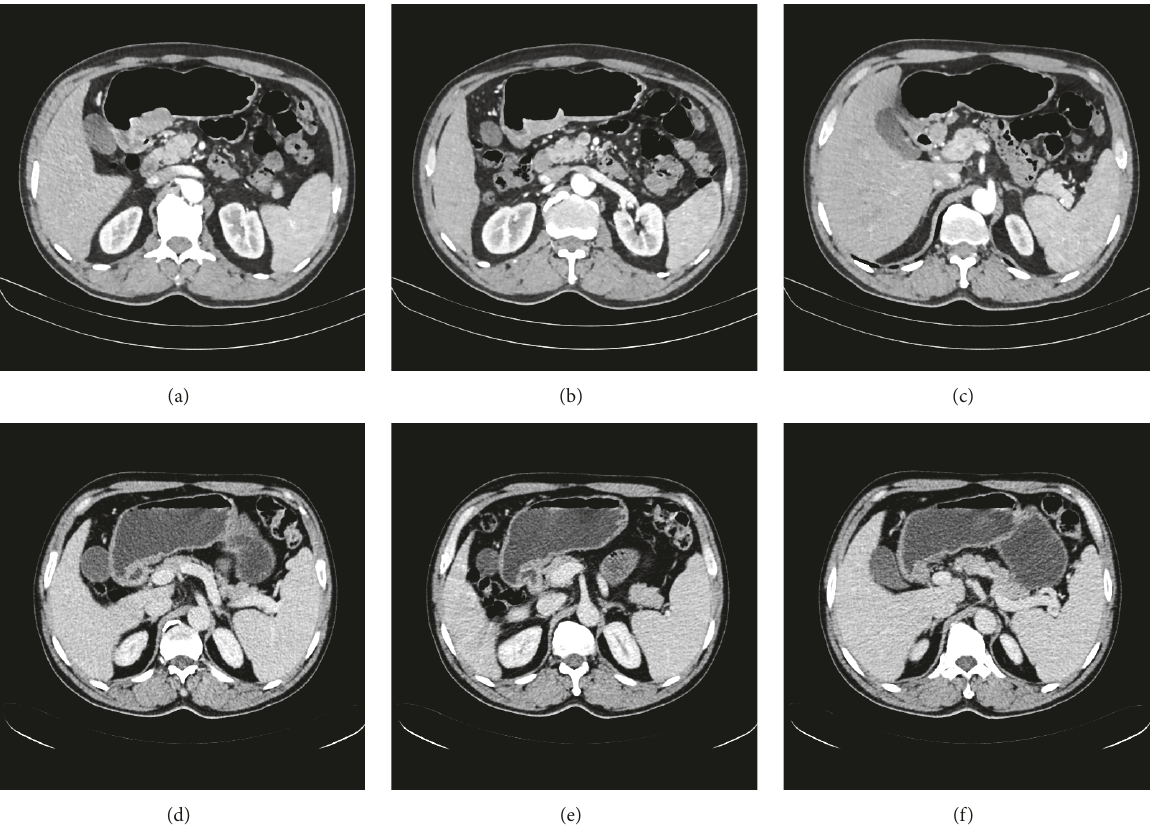
Figure 3: Initial abdominal computed tomography scan (a ∼ c) and follow-up scan after three cycles of EOX chemotherapy (d ∼ f) . (a, b, and c) Irregular wall thickening on the lesser curvature side of the gastric antrum with mass formation, large ulceroinfiltrative, and multiple metastases to neighboring lymph nodes; (d, e) scan shows that the mass of the gastric antrum decreased in range from approximately 7cm to less than 3.3cm; (f) disappearance of metastatic lesion of neighboring lymph nodes that had been previously